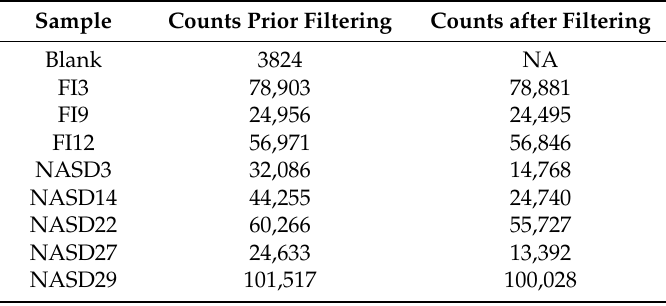
Table 2. Sequence counts per sample prior and after filtering of operational taxonomic units (OTUs) present in blank control. Sequence counts were obtained using the biom summarize-table